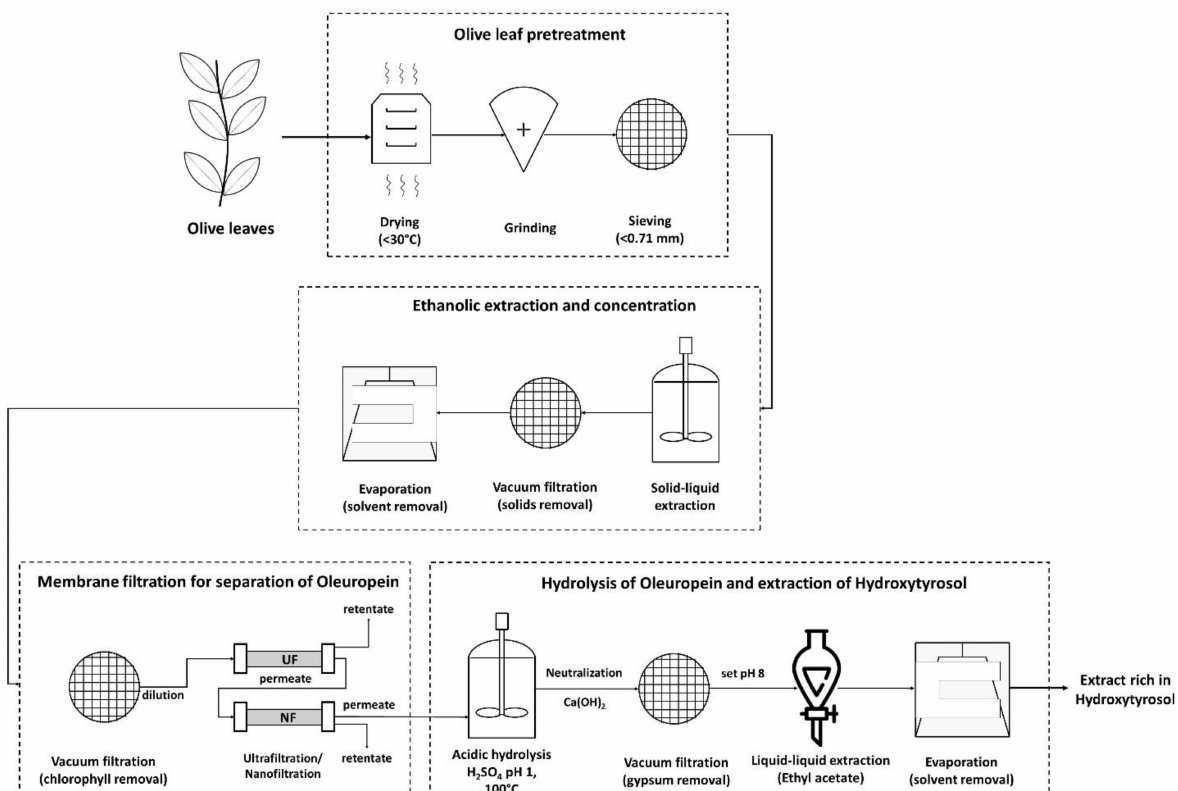
Figure 2. Process scheme in which the membrane filtration step takes place after the solid–liquid